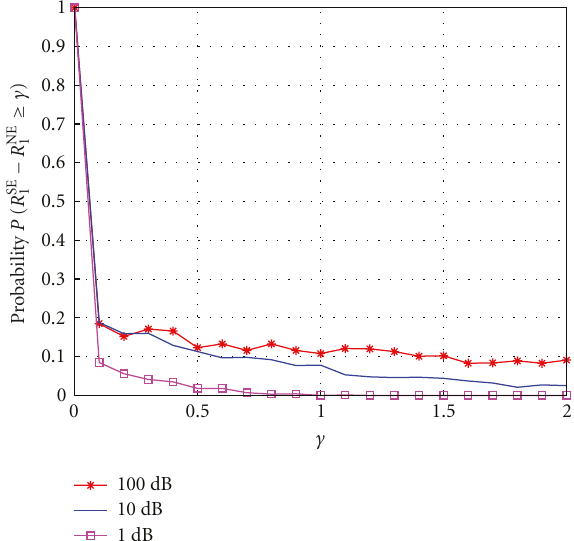
Figure 8: Probability when the NE approach is worse than the Stackelberg approach for the leader, for several SNR values.